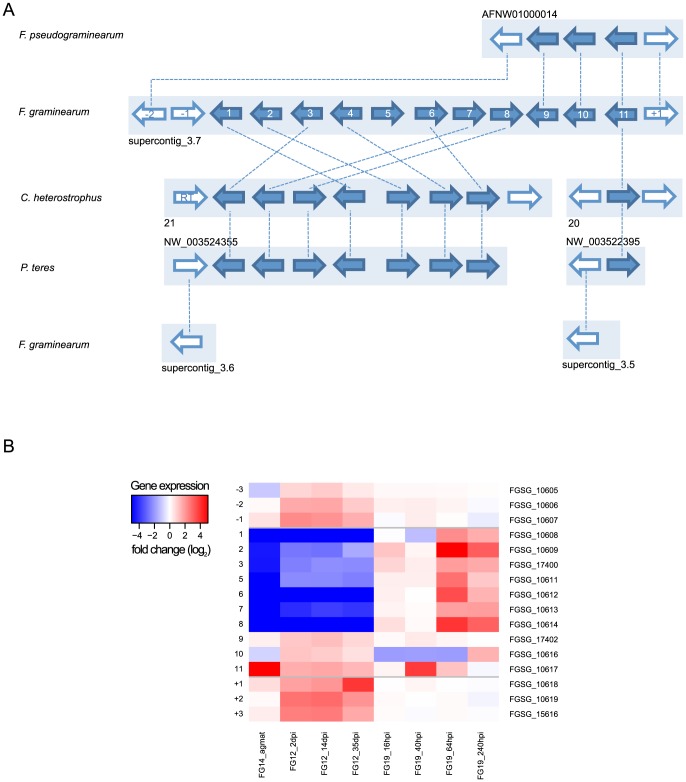
Orthologous genes and regulation of predicted C62 cluster.(A) Predicted gene cluster in Fusarium graminearum and orthologous genes in F. pseudograminearum, Cochliobolus heterostrophus and Pyrenophora teres. (solid dark blue arrows) on their respective supercontigs (light blue boxes). Adjacent genes are shown in white, dashed lines between genes illustrate orthologous groups. Enumeration in F. graminearum is according to Table 5. Reverse transcriptase in C. heterostrophus is indicated as “RT”. (B) Heatmap illustrates fold changes in gene expression (log2 scale) of cluster and adjacent genes between experimental conditions. Genes are listed in chromosomal order on y-axis. Horizontal grey bars show boundaries of predicted clusters. Abbreviations of experimental conditions on x-axis are according to Table 6. No expression data is available for FGSG_17401, as a distinct mapping of probes on this gene model was not possible.